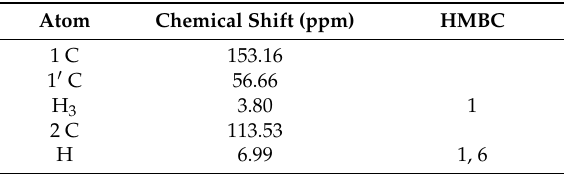
Figure 1. Structure, numbering and HMBC correlations of the title compound. Table 1. 1 H, 13 C chemical shifts and HMBC correlations of the title compound.